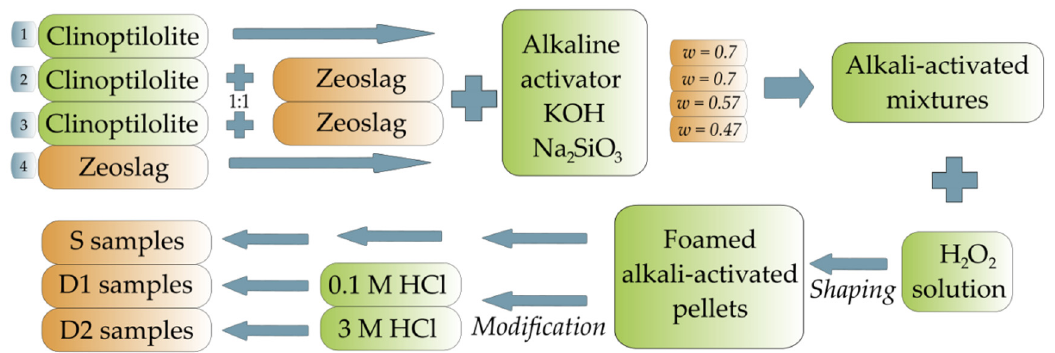
Figure 1. Graphical scheme of synthesis of alkali-activated zeolite foams and subsequent post-synthetic modification.